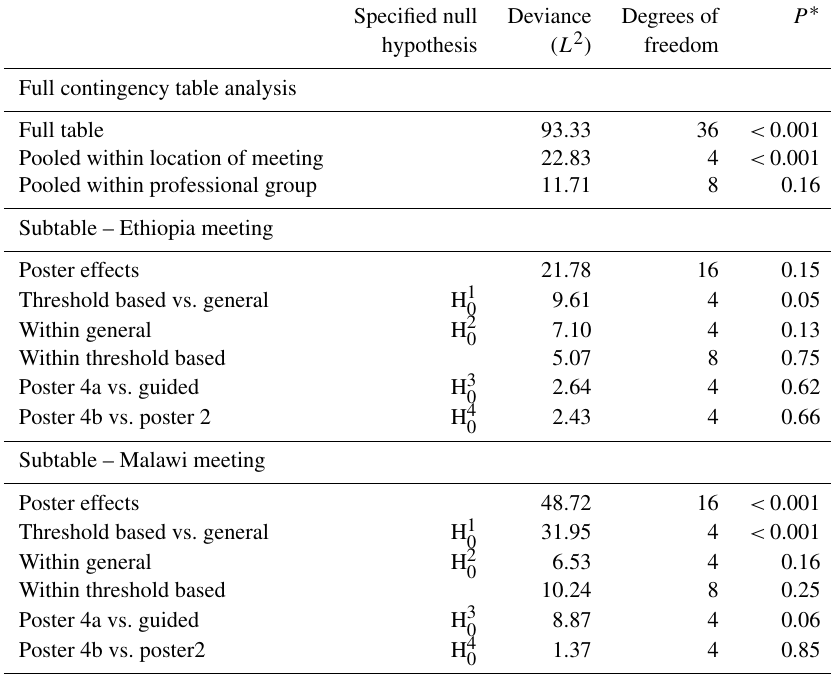
Table 4. Analysis of Q1 according to the location of the meeting, professional group and methods that the latter tested on separate location